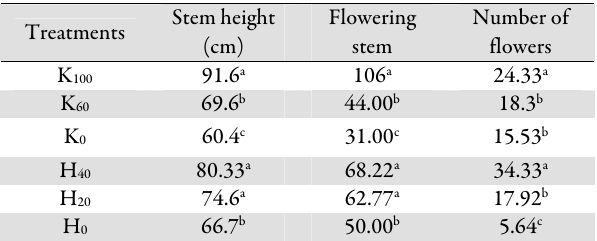
Tab. 1. Effect of potassium sulphate and humic acid fertilizers on morphological attributes